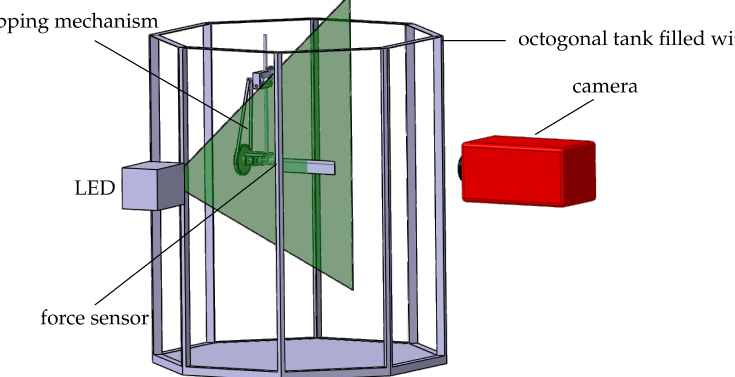
Figure 4. Schematic of the experimental setup displaying the flapping mechanism inside an octagonal tank filled with water, the particle image velocimetry (PIV) light-sheet and PIV camera. The flapping mechanism is immersed in an octagonal tank filled with water and an outer diameter of 0.75 m. A 4 mm-thick light-sheet is generated by a high-power light-emitting diode (LED) (LED Pulsed System, ILA_5150 GmbH, Aachen, Germany) and a cylindrical lens [34]. A 70 mm × 94 mm field of view is recorded by a pco pixelfly camera (1024 px × 1372 px resolution). Phase-locked particle image velocimetry (PIV) is carried out by triggering the LED and the camera synchronously to get a single image pair for a selected stroke angle. By rotating the initial stroke position relative to the light-sheet, the wing gets captured at different phase angles. A total of 24 flapping cycles are captured and averaged for 13 different stroke angles. The raw images are processed with a multi-grid algorithm and a final interrogation window size of 32 px × 32 px with an overlap of 50%. This leads to a physical resolution of 1 mm or 0.03